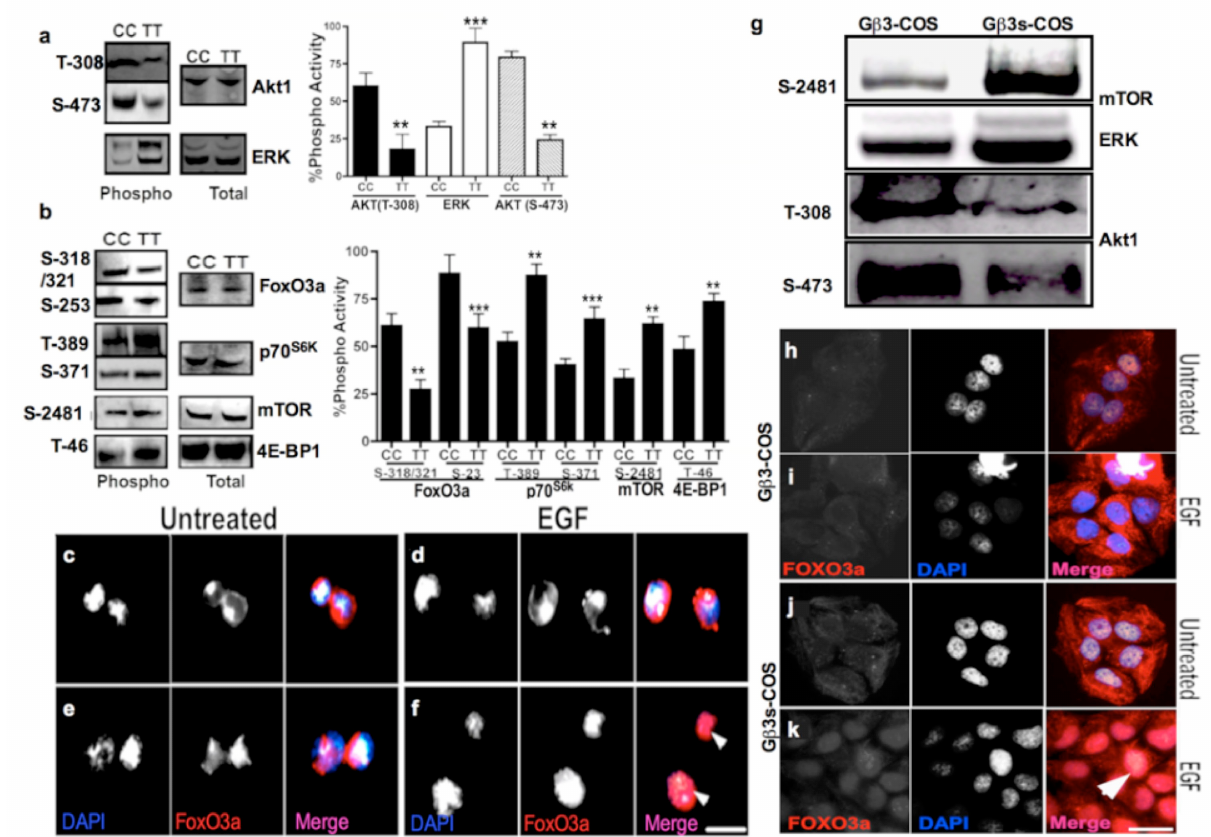
Figure 3. Gβ3s subunit hyper activates ERK overcompensating for the lack of AKT activity. Phospho immuno reactivity of ERK2 and AKT1 at relevant residues are shown in CC and TT lymphoblast protein extracts (a). TT lymphoblast protein extracts showed significant changes in relative phosphorylation activity when compared to CC lymphoblasts in PI3K-AKT pathway substrates such as Foxo3a, mTOR, p70 S6k and 4E-BP1 at relevant residues (b) which was confirmed by semi quantitative densitometry analyses as described in materials and methods. Data presented in all panels are the mean with standard error (bars) of n = 3 independent experiments. Lysates from stable COS-7 clones showed similar kinetics in terms of ERK and AKT1 phosphorylation as observed in lymphoblastoid cells (g). Statistical significance is shown as *P<0.05, **P<0.01, ***P<0.001. Foxo3a immuno staining of lymphoblast cells was performed using total Foxo3a antibody at both basal and EGF stimulated condition as mentioned in methods (c-f). TT lymphoblast cells and G b 3s- COS7 cell showed distinct nuclear Foxo3a staining. White arrows indicate co-localisation with DAPI (blue) upon EGF stimulation confirming nuclear retention (f & k). This particular nuclear staining was not observed in CC lymphoblasts and G b 3-COS cells both in untreated (c & h) and EGF stimulated conditions (d & i). Images were taken from different fields of view under a 40x objective with further 1.5x magnification. Bar = 13 m